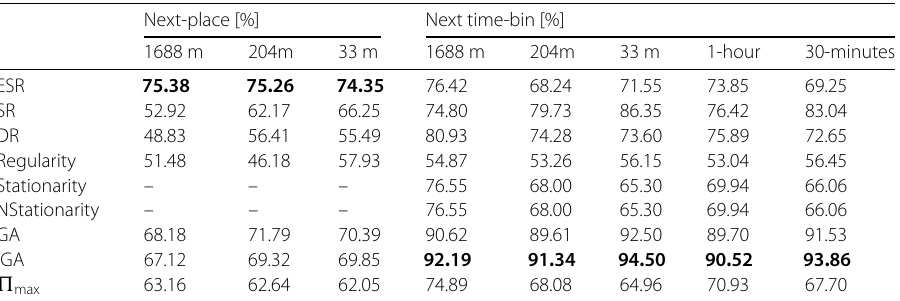
Table 6 Spearman’s correlation of the evaluated metrics and accuracy of predictions calculated on the two types of mobility sequences of various spatio-temporal resolution Next-place [%] Next time-bin [%] 1688 m 204m 33 m 1688 m 204m 33 m 1-hour ESR 75 .